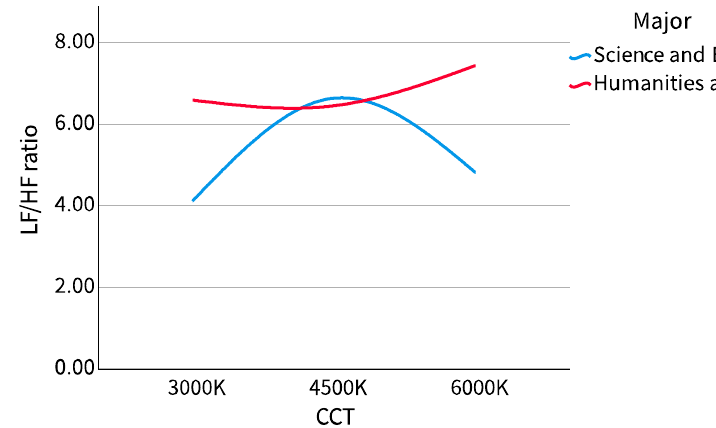
Figure 7. LF/HF ratio boxplot (major).